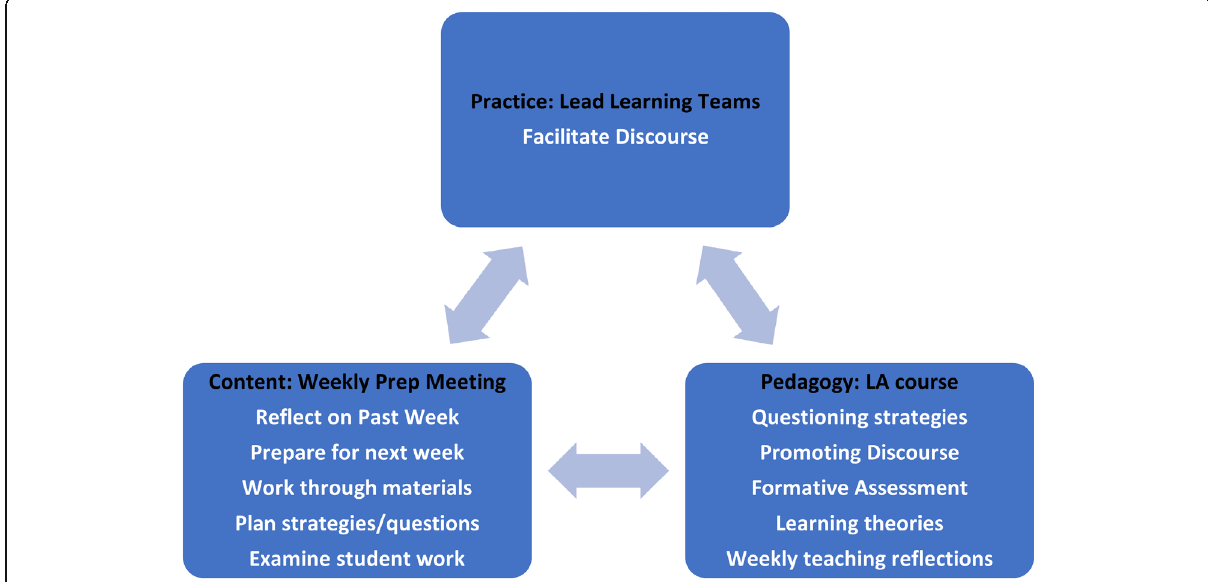
Fig. 1 The three main pillars of the LA experience (Learning Assistant Alliance 2016). In the two programs under study here, the LAs attend lecture, hold weekly office hours, and attend weekly planning meetings with their faculty member. LAs are paid a monthly stipend for their work. All new LAs are required to take a 2-credit hour Introduction to Science Teaching and Learning course where they learn about the principles of teaching, including theories and techniques (see course syllabus in the Additional file